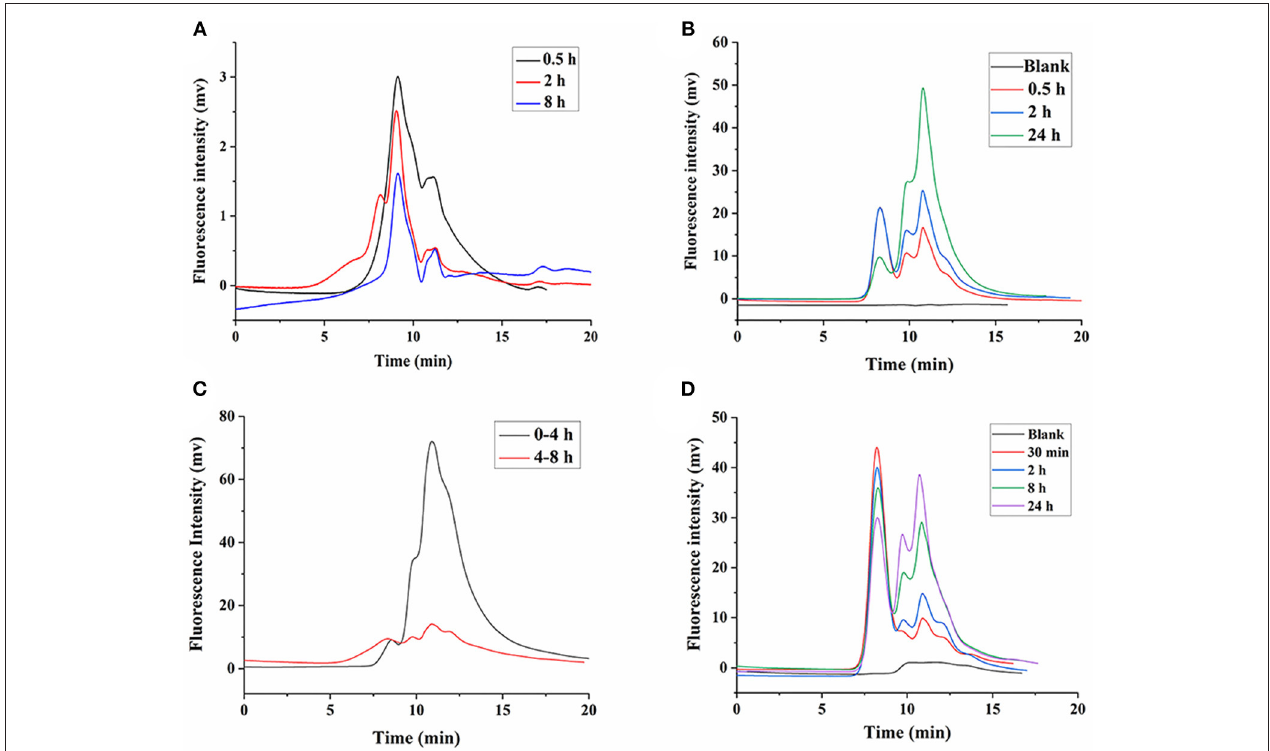
FIGURE 7 | Degradation of FLNT in kidney and urine. (A) Degradation of FLNT at different time points in kidney in vivo . (B) Degradation of FLNT at different time points in kidney homogenate in vitro . (C) Degradation of FLNT at different time points in urine in vivo . (D) Degradation of FLNT at different time points in urine in vitro